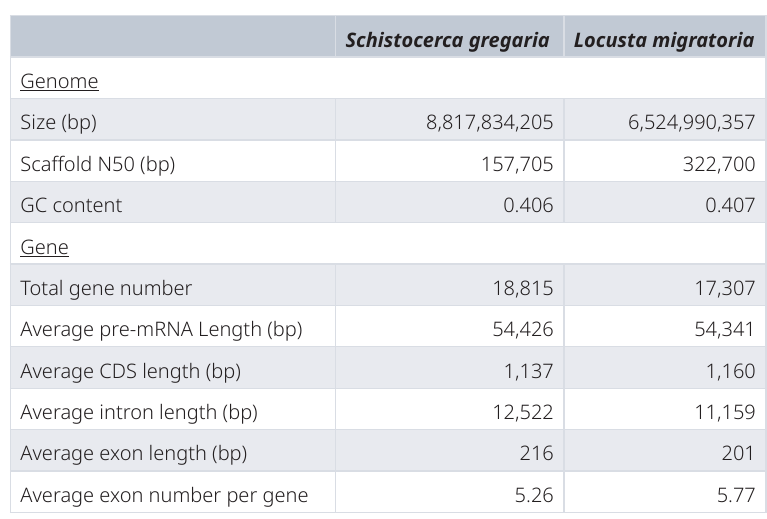
Table 3. Summary statistics on gene information for the desert locust, Schistocerca gregaria , and the migratory locust, Locusta migratoria (Wang et al., 2014).